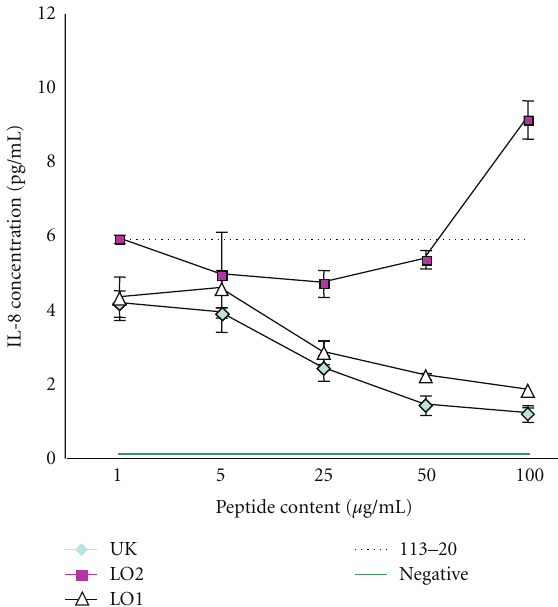
Figure 3: IL-8 production from MONO cells activated by S. sanguinis antigen was suppressed by LO1 and UK in a dose- dependent